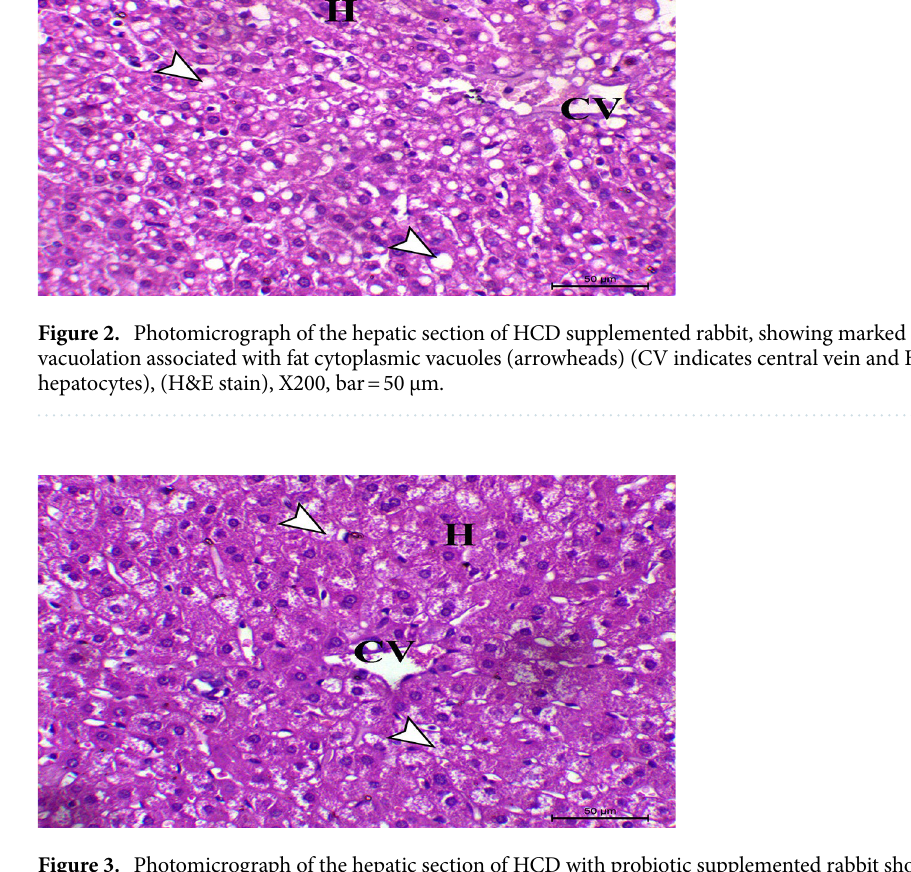
Figure 3. Photomicrograph of the hepatic section of HCD with probiotic supplemented rabbit showing marked decrease hepatic fatty changes with mild glycogen infiltration (arrowheads) (CV indicates central vein and H indicates hepatocytes), (H&E stain), X200, bar = 50